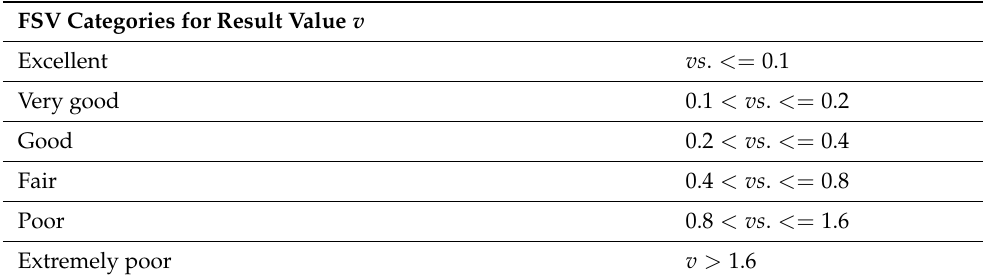
Table 1. Categories for the similarity of the two signals according to the FSV results. FSV Categories for Result Value v